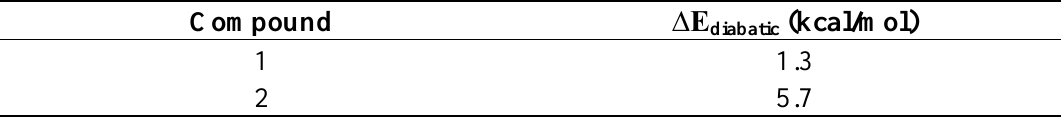
Table 4. Calculated energy difference (∆E compounds 1a and 2a.